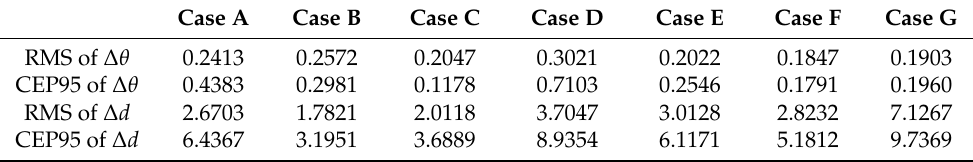
Table 4. The control accuracy of heading deviation and vertical distance deviation.